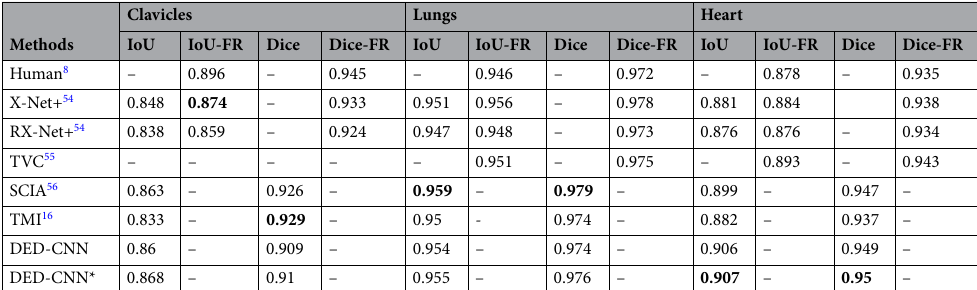
Table 1. Comparative evaluation of the proposed method segmentation performance with the existing SOTA algorithms was reported on the JSRT dataset. The performance of the models was trained using full resolution (FR) (i.e., 2048 × 2048) and reported with IoU-FR and Dice-FR. The proposed method (*) represents the segmentation results of the model trained with the augmented dataset. Significant values are in bold.